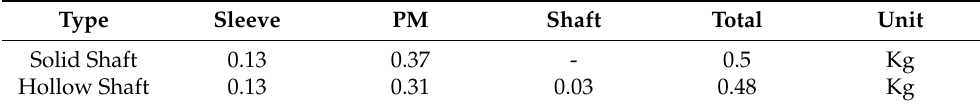
Table 4. Rotor weight according to shaft